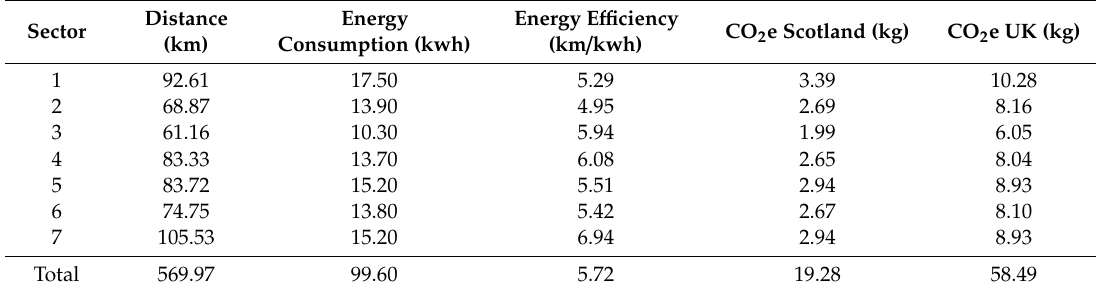
Table 8. Travelled distance, energy consumption and CO 2 emissions.